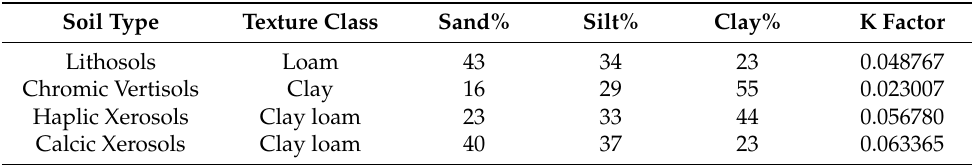
Figure 5. Boxplot shows the distributions of the ~5% random selected pixels from R-factor values for the six equations used in this study, which is very rough. Table 9. Soil types, textures, and the K-factor values. Table 9. Soil types, textures, and the K-factor